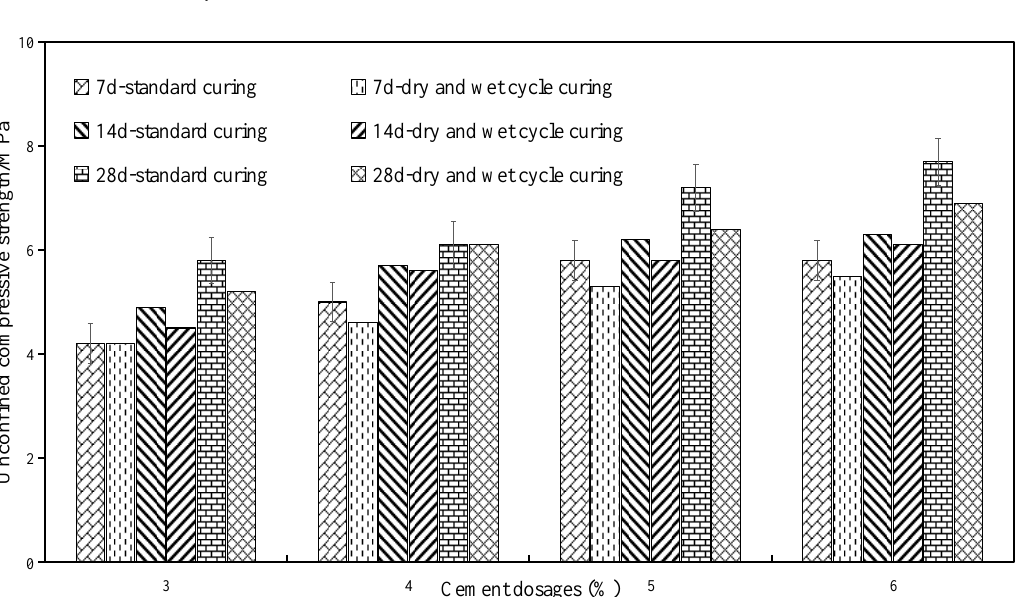
Figure 2. The strength of CSPB specimens under different curing environments and cement dosage.